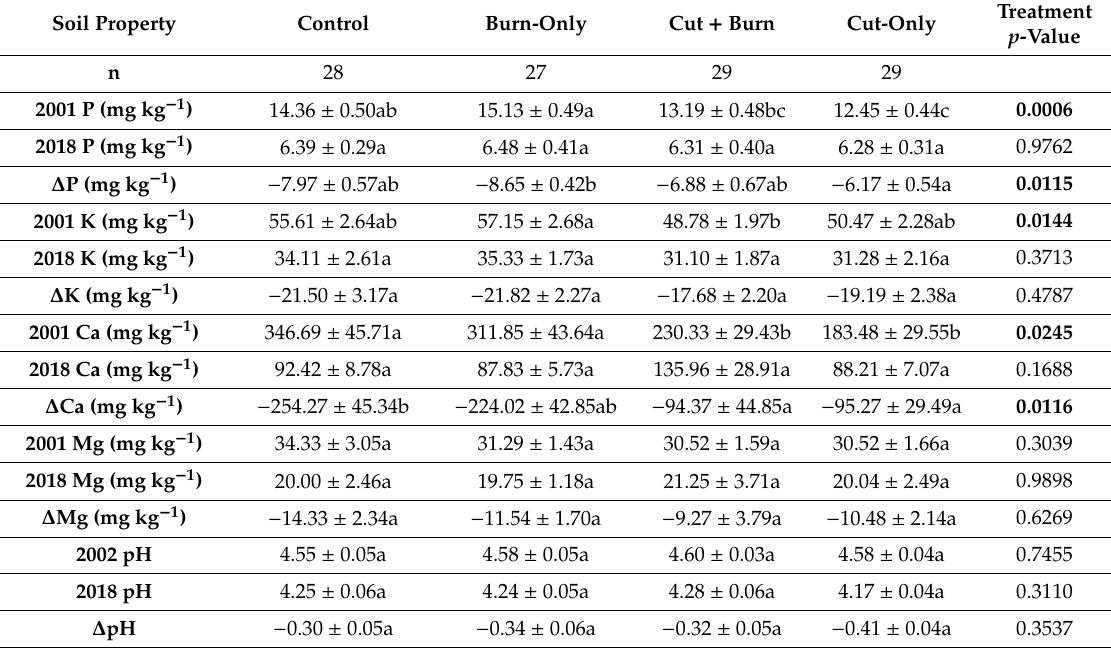
Table 3. 2001 (or 2002 for soil pH) and 2018 mineral soil (0–10 cm soil depth) calcium (Ca), magnesium (Mg), phosphorus (P), potassium (K), and pH values ( ± mean standard error) and their di ff erences ( ∆ ) obtained on the Green River Game Lands near Asheville, NC, USA. Significant di ff erence determination for mean and mean ∆ values are bolded ( α = 0.05) and Tukey’s HSD di ff erences between treatments (across rows) are noted by letter